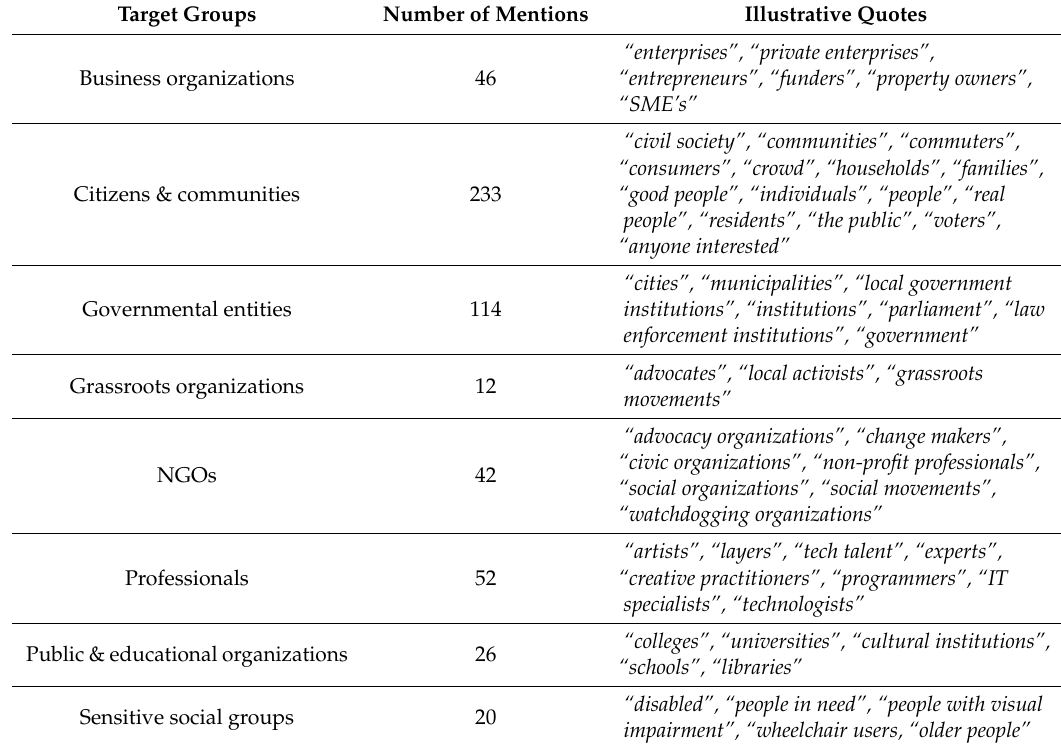
Table 3. The Target Groups of International Civic Technology